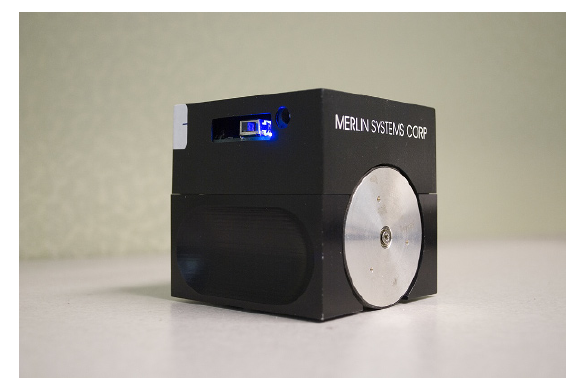
Figure 5. Merlin Systems Miabot Pro BT V2.0